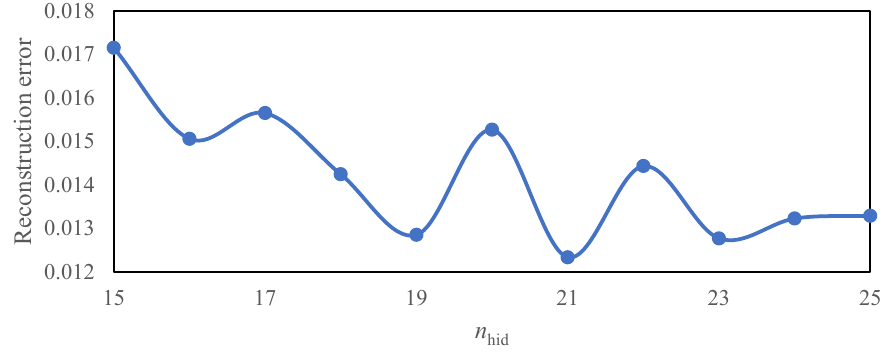
Figure 13. Relationship between n hid and reconstruction error. Table 10. Table of n hid and reconstruction error.